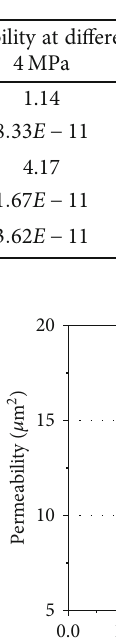
Table 2: Gas permeability test data and calculation results.